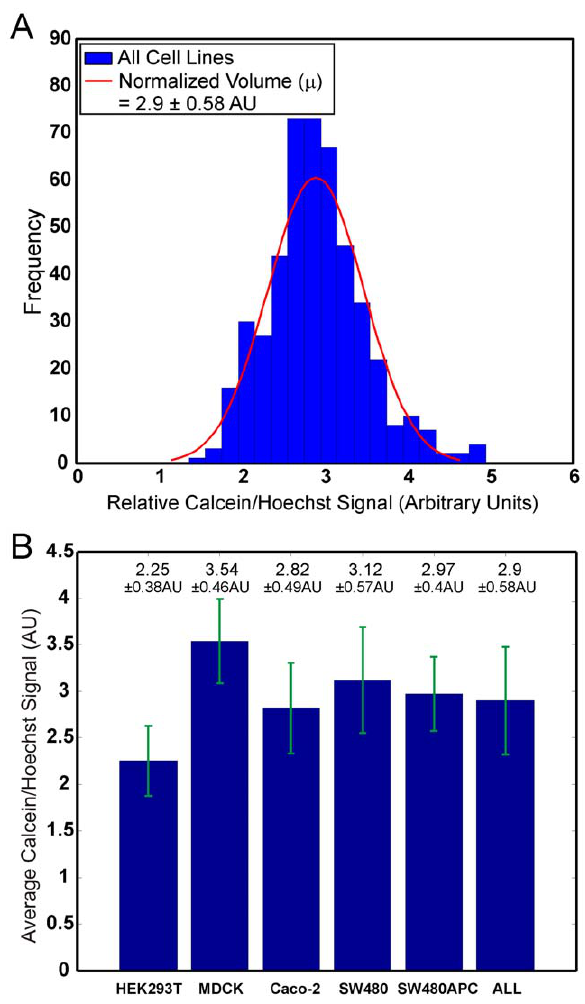
Figure 2. Population statistics of all cell types. Population statistics of all cells showing the (A) histograms of normalised volume (Calcein AM/Hoechst) and the (B) average normalised volume column chart. (AU: Arbitrary Units).